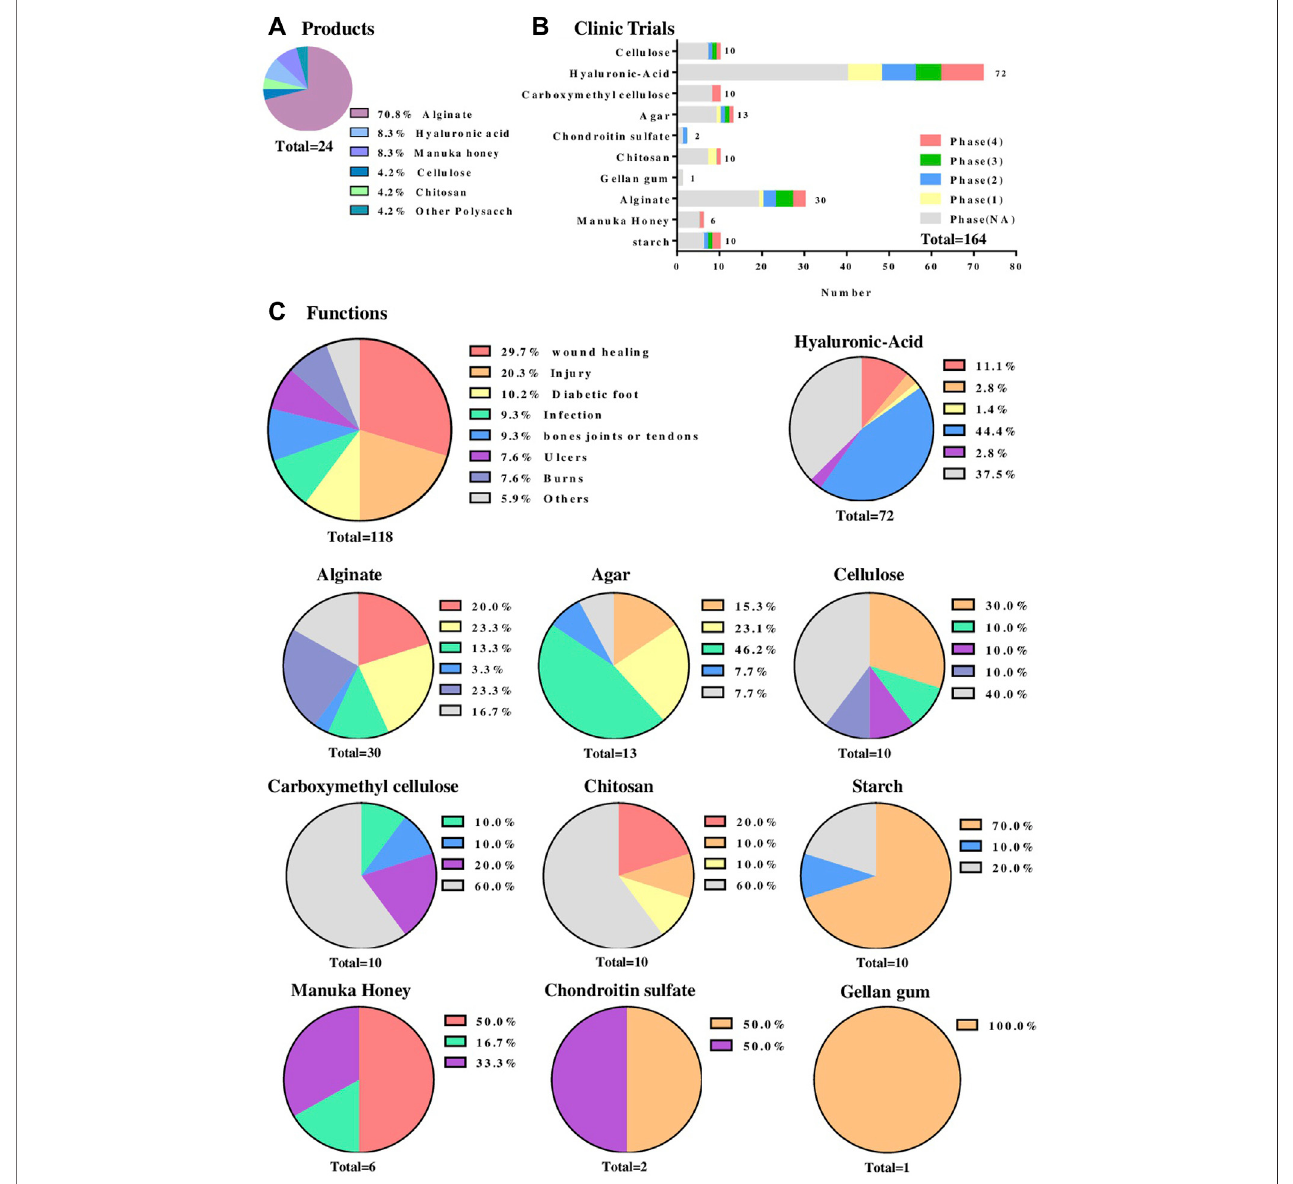
FIGURE 2 | Clinical application of the polysaccharide-based hydrogel wound dressing. (A) A statistical chart of the main polysaccharide components of polysaccharide-based wound dressings registered with the FDA. Data Sources from www.accessdata.fda.gov/. (B) The statistical chart of the main polysaccharide components of polysaccharide-based hydrogel wound dressings that are undergoing clinical trials and the phase states of these hydrogels. Data Sources from https:// clinicaltrials.gov/. (C) The types of wounds that different polysaccharide-based hydrogel wound dressings deal with which are undergoing clinical trials. The fi rst fi gure is the overall function statistics. Data Sources from https://trialsearch.who.int/.